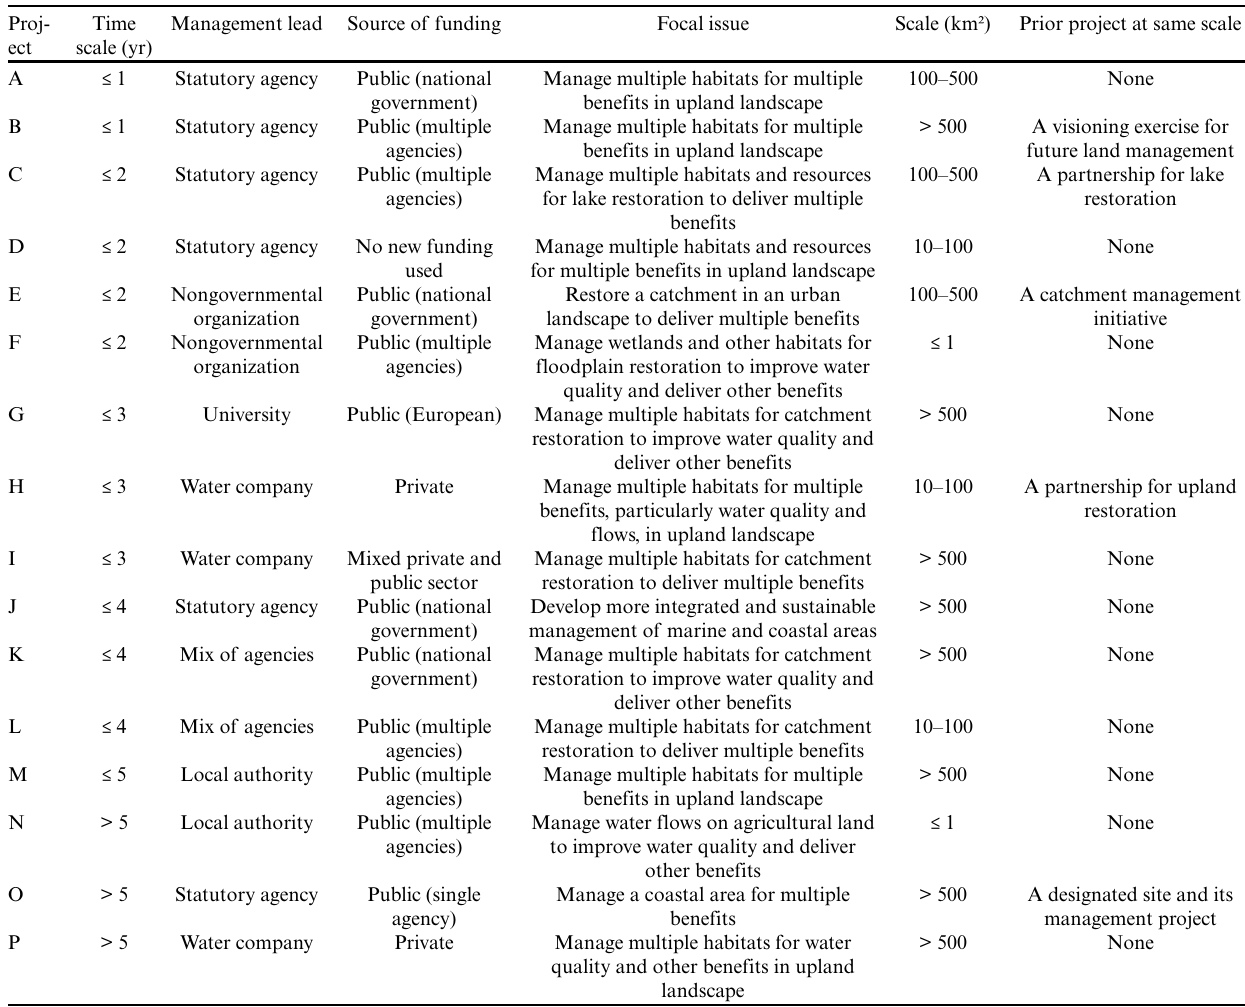
Table 1. Basic attributes of the 16 projects used as